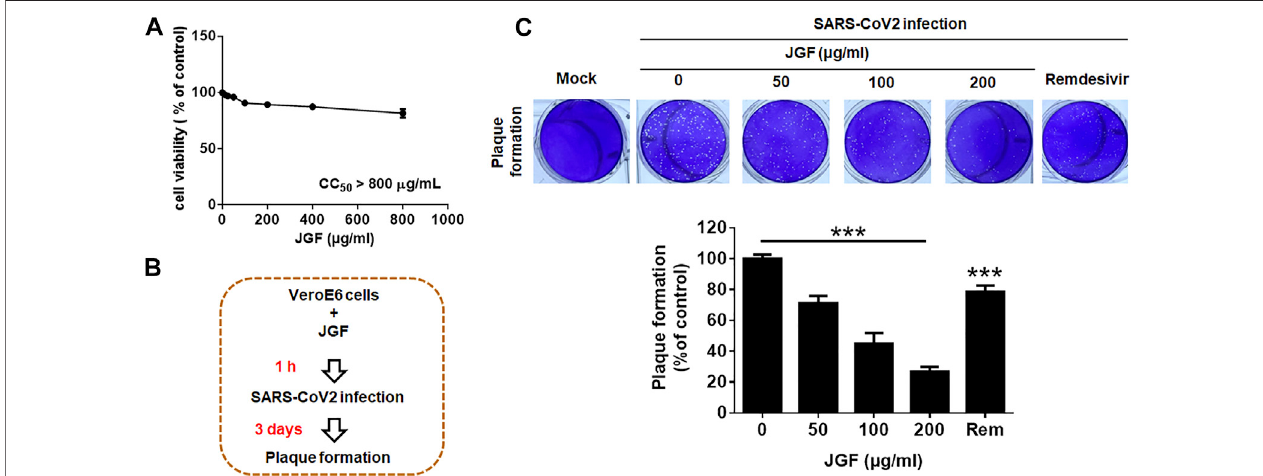
FIGURE 6 | JGF inhibits plaque formation for SARS-CoV-2 in Vero E6 cells. (A) Vero E6 cells were treated with various concentrations of JGF (0 – 800 μ g/ml) for 72 h. Each group of JGF-treated samples was normalized against an untreated control. Cell viability was determined using the MTT assay. (B) Vero E6 cells were pre- treated with JGF (0 – 200 μ g/ml) for 3 h and then infected with SARS-CoV-2 for 3 days (C) The plaque was stained with crystal violet. Data were representative of three separate experiments and were presented as the mean ± SD; error bars indicated